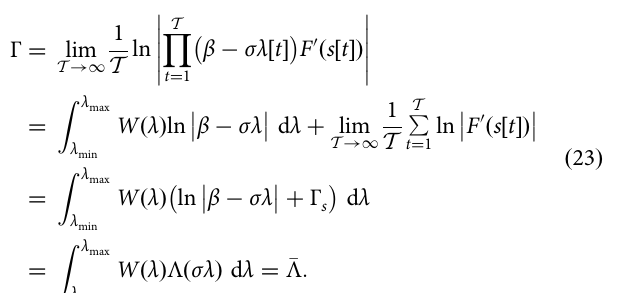
zero mean and standard deviation 0.1/ n (10% of the average edge weight) are added to the strength of each edge at every time step.